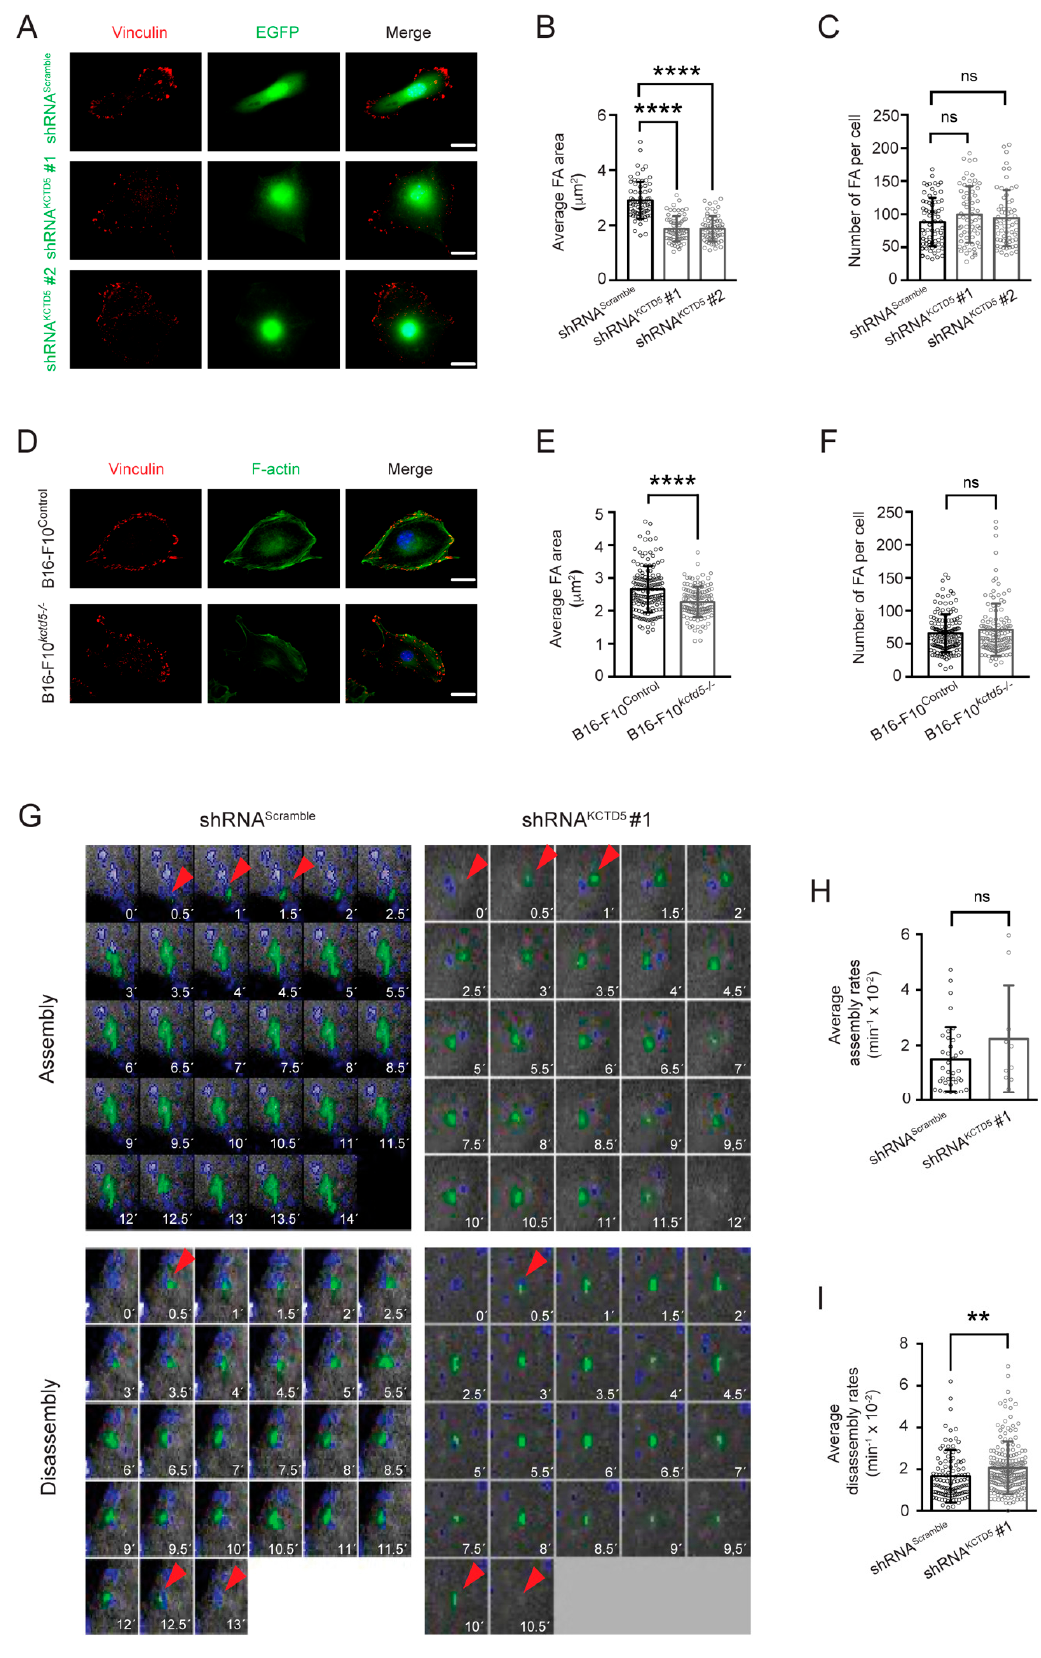
Figure 4. KCTD5 regulates focal adhesion size of B16-F10 cells. ( A ) Representative images of B16-F10 cells transfected with shRNA Scramble , shRNA KCTD5 #1 or shRNA KCTD5 #2 encoding plasmids.